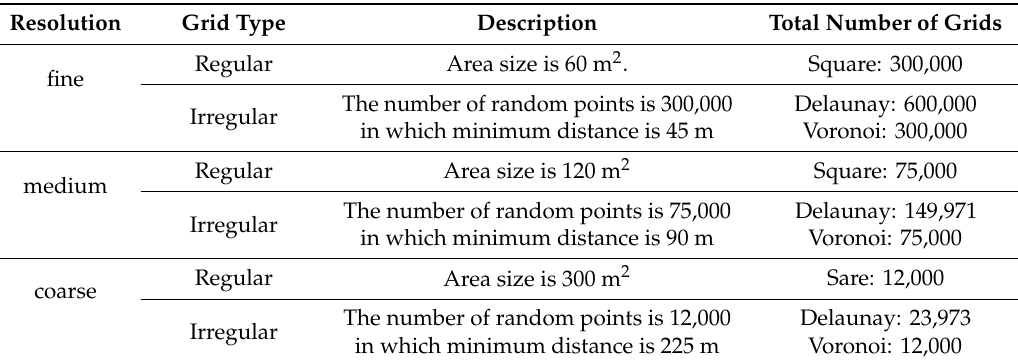
Table 7. Three resolutions in three grid